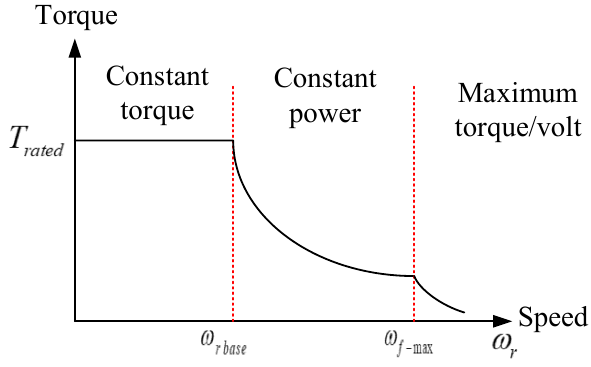
Figure 5. Torque-speed curve of the SPMSM.